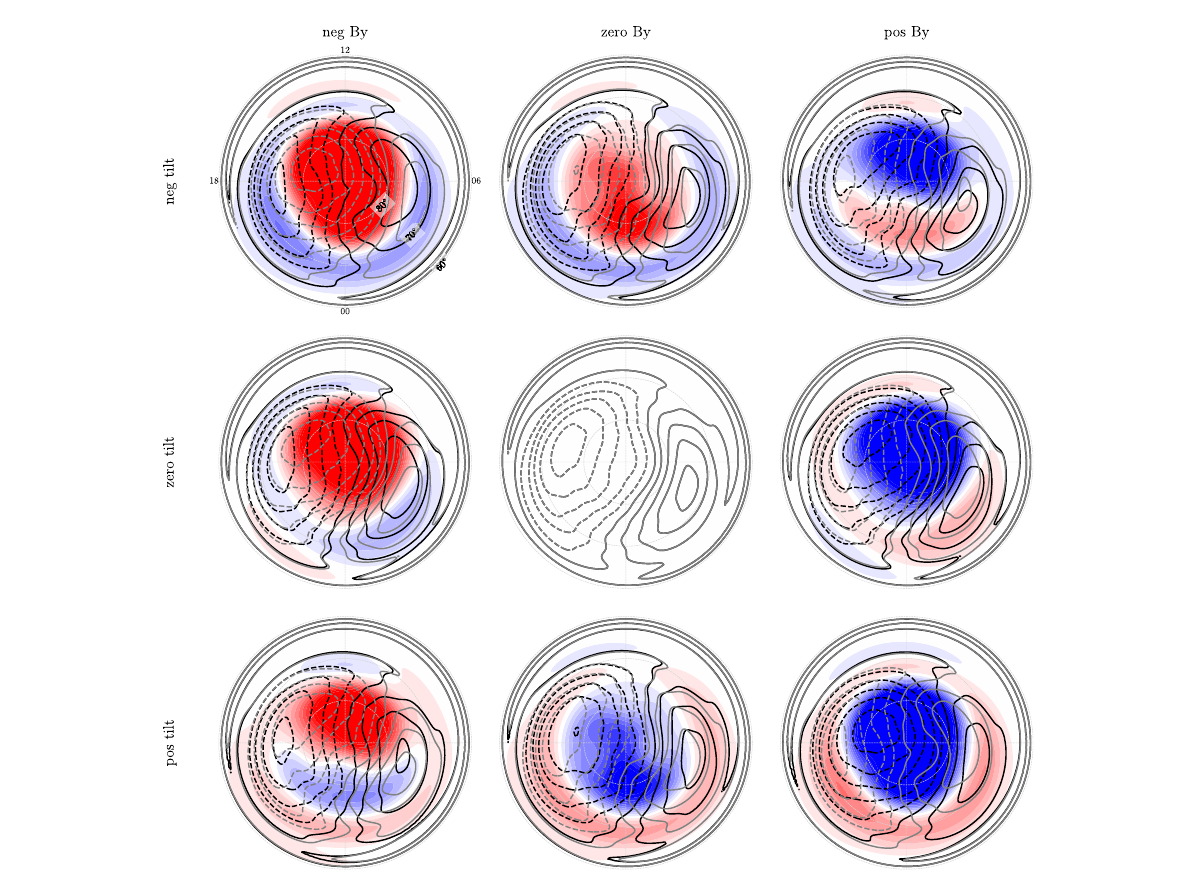
FIGURE 3 Nine different Weimer (2005a),Weimer(2005b) electricpotentialsfrom thesouthern (grey) and northern(black)hemispheres.The colorshows (cid:14) (cid:10)(cid:10)(cid:10)(cid:10)(cid:10)(cid:10)(cid:10) thepotentialmismatchatmatchingcoordinates,usingthecolorscalefromFigure1.Forallpanelsthesolarwindvelocityis400 km/s,density5 cm − 3 , (cid:2) 5 nT. The three columns correspond to three different combinations of IMF clock angle, arctan2 ( B y , B z ); − 225 ° , − 180 ° , and 135 ° . The + B 2 B 2 and y z three rows correspond to three different combinations of dipole tilt angle: ψ = − 20 ° , 0 ° , and 20 °